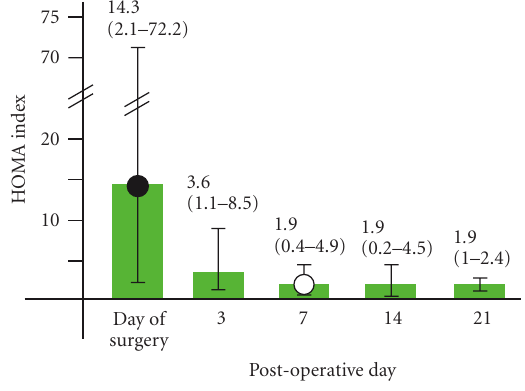
Figure 3: HOMA index at the day of surgery and 3, 7, 14, and 21 days after BPD-DS (27 patients). Green bars indicate mean HOMA index (whiskers indicate minimum and maximum values).